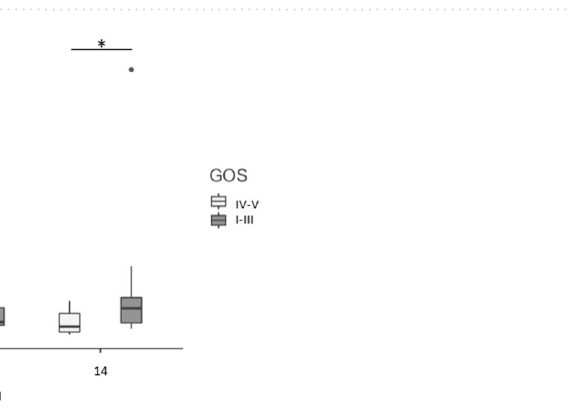
Figure 3. Diagnostic and Prognostic value of serum and CSF markers . High serum glutamate levels at days 5–7 correlated with higher HH ( A ). Serum glutamate levels at days 0–3, 5–7, and 14 post-SAH correlated with the presence of ischemia (hypodense lesions) on a brain CT scan ( B ) and increased intracranial pressure (ICP) ( C ). ( D - F ) Correlation between serum glutamate levels at days 0–3, 5–7, and 14 post-SAH and presence of neurological deficits at discharge ( D ), clinical outcome defined as “good” (GOS IV–V) versus “poor” (GOS I–III) 3 months after SAH ( E ), and hospital length of stay (LOS) ( F ). Data are expressed as the median and interquartile range. Statistical analysis was performed using the Mann Whitney test, * p < 0.05, ** p < 0.01.